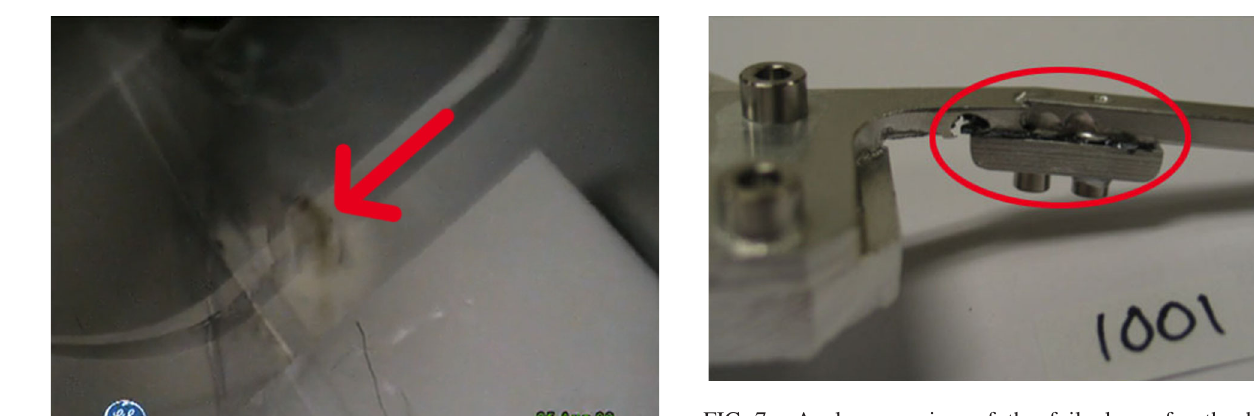
FIG. 7. A close-up view of the foil clamp for the bracket shown in Fig. 5. The ellipse indicates the damage caused by vacuum breakdown. (The figure was reproduced from Ref. [13].)